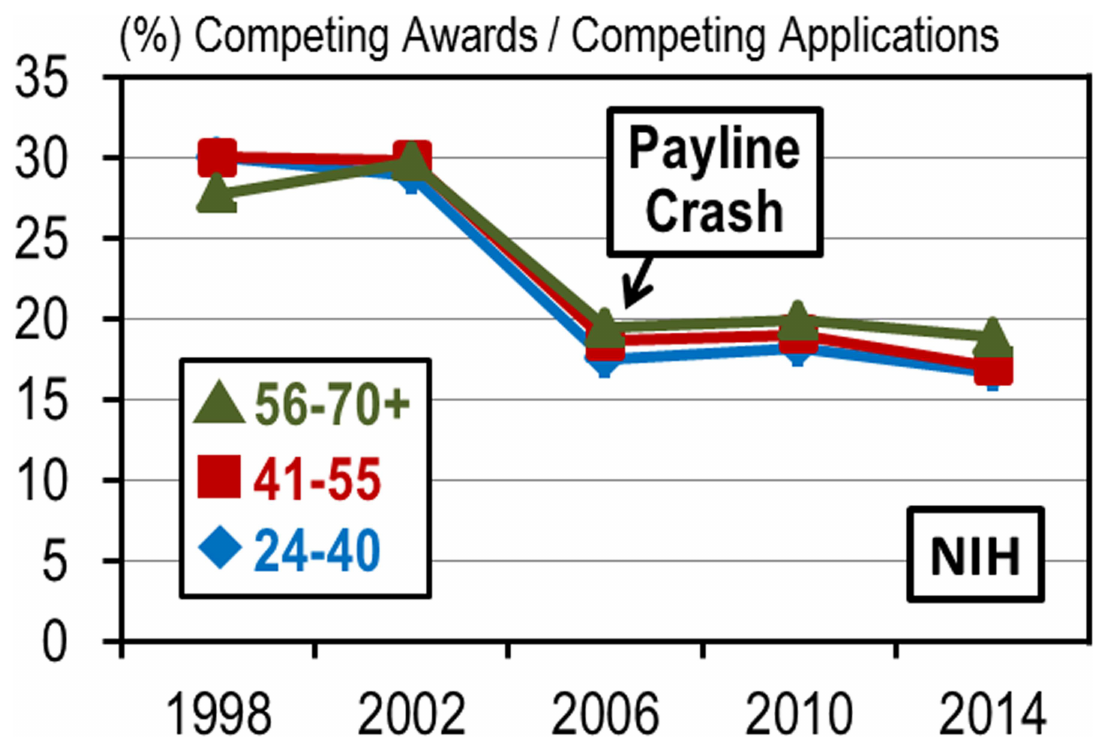
Fig 5. Prospects of Receiving a New Award or Renewing an Existing Award are Approximately Equal among the Age Groups. RPG competingaward rates at NIH by age group for select years between1998 and